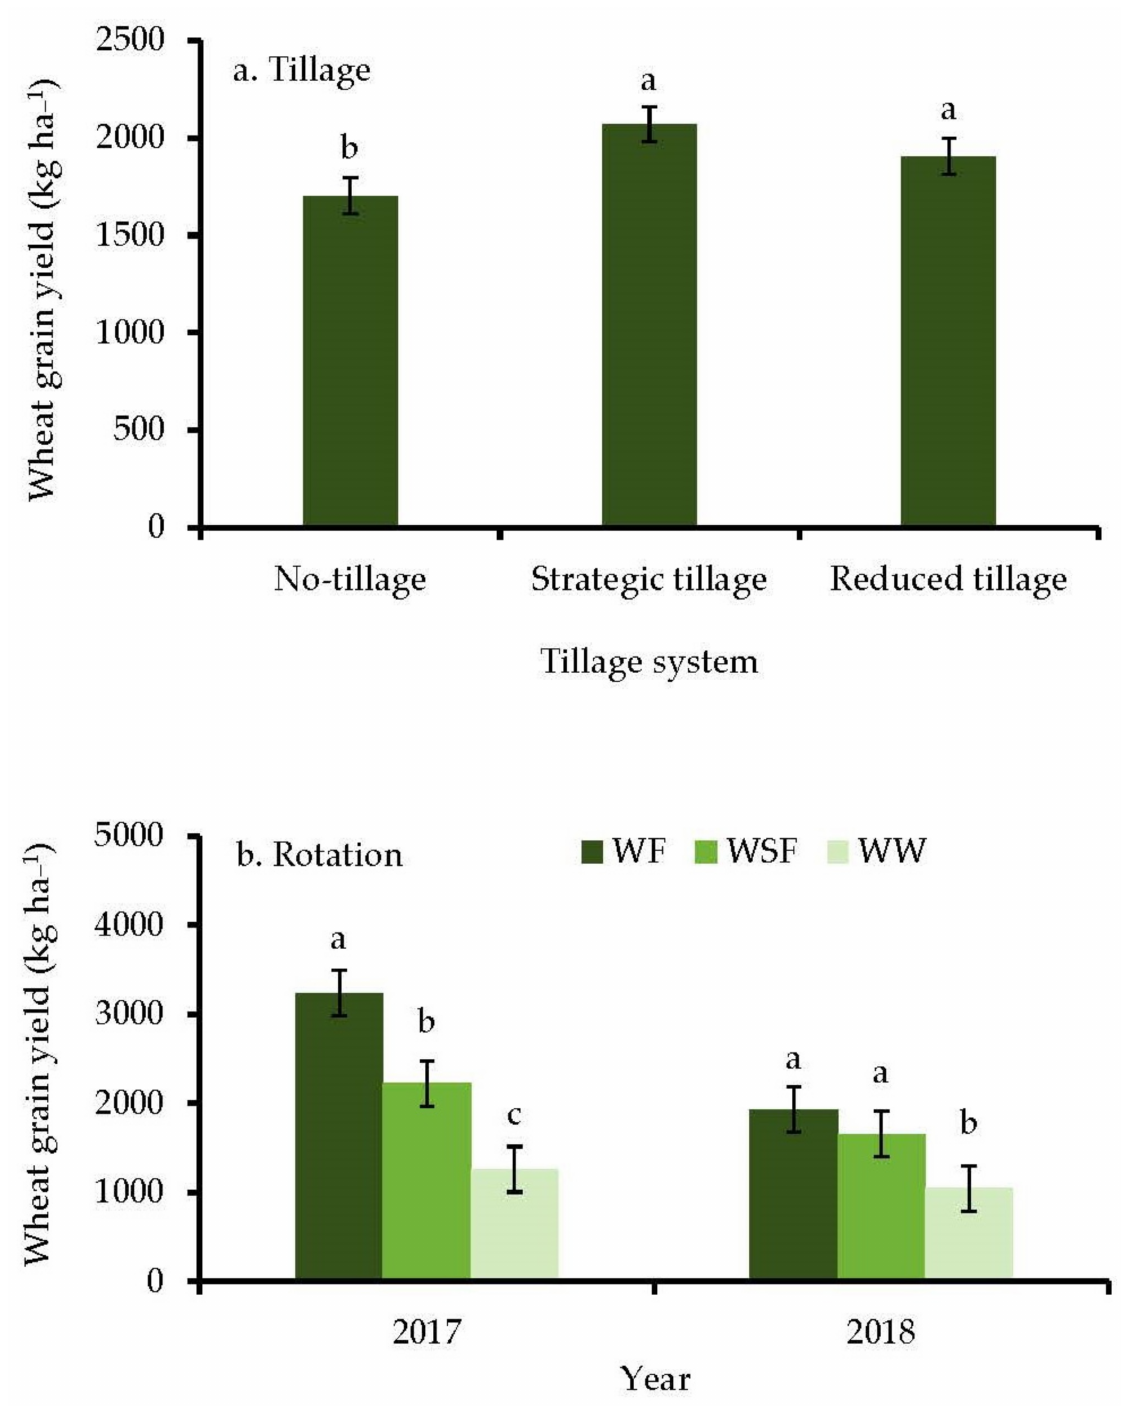
Figure 4. Winter wheat grain yield averaged over 2017 and 2018 growing season at Hays, KS affected ( a ) tillage and ( b ) crop rotation system. Means followed by the same lower-case letter(s) within a crop rotation or year are not signifi- cantly different using the least squares means (LSMEANS) and adjusted Tukey multiple comparison procedure ( p > 0.05). WF = Wheat-fallow; WSF = wheat-sorghum-fallow; WW =